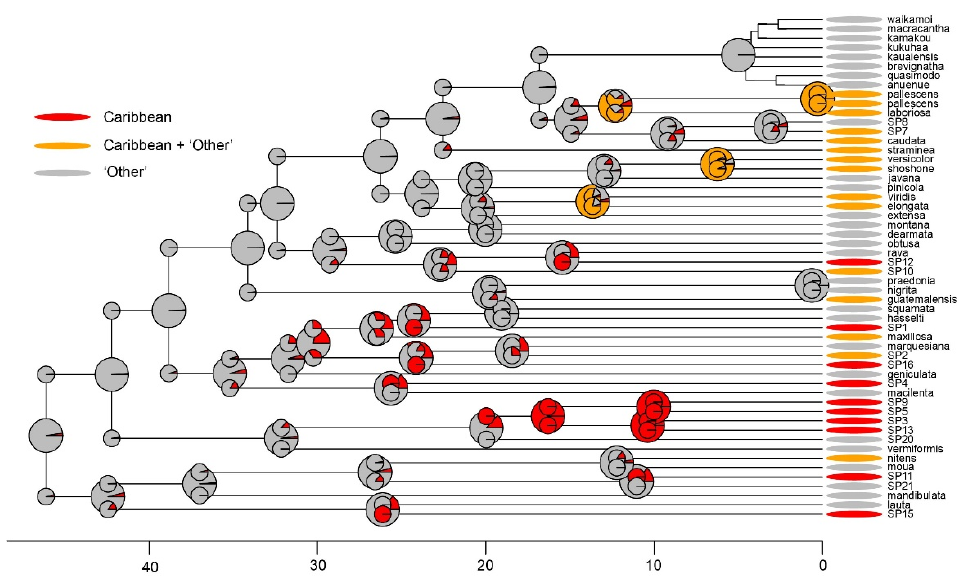
Figure 5. Ancestral area estimation of Tetragnatha . The biogeographical analysis in BioGeoBEARS using the most suitable model for our data (BAYAREALIKE + J, max_range_size = 2), reveals multiple origins of the Caribbean taxa from the outside sources. A single subclade (SP 13, 3, 5, 9) has a well-supported Caribbean ancestral range. Evidently, multiple founder events and range expansion took place throughout Tetragnatha ’s biogeographic history in the Caribbean.